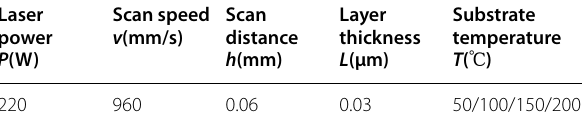
Table 6 Process simulation molding parameters Laser